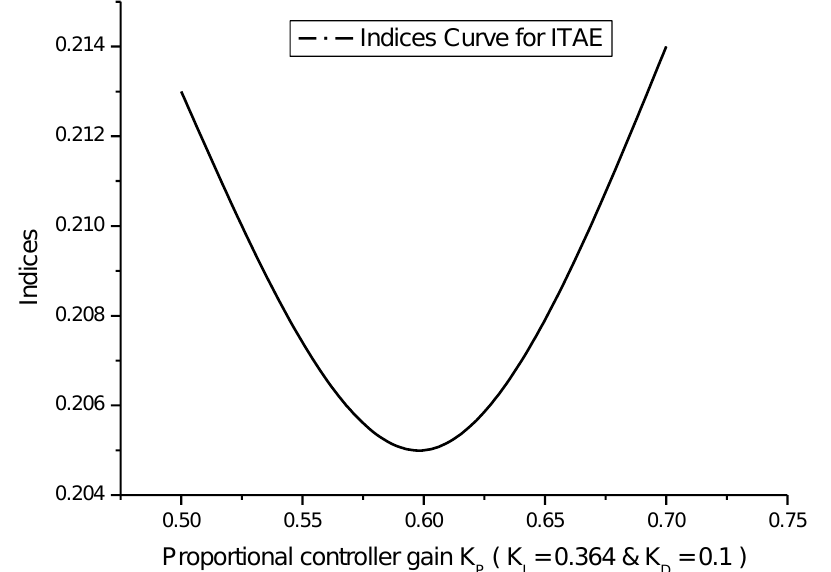
Figure 4. ITAE performance indices curve.